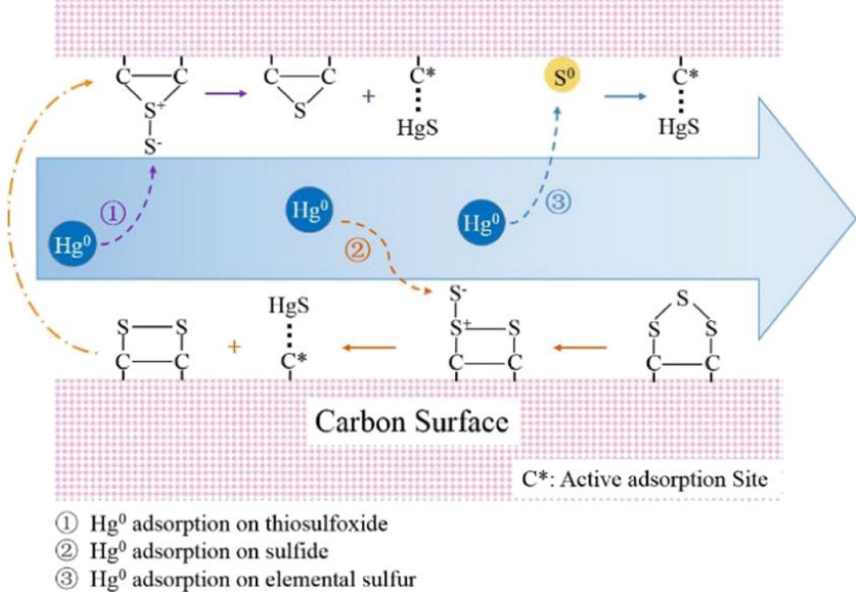
Figure 5. Possible reaction scheme of mercury capture by nonoxidized sulfur species in SO 2 activated cokes [48] . Reprinted/adapted with permission from Ref. [48]. 2020, Energy and Fuels.